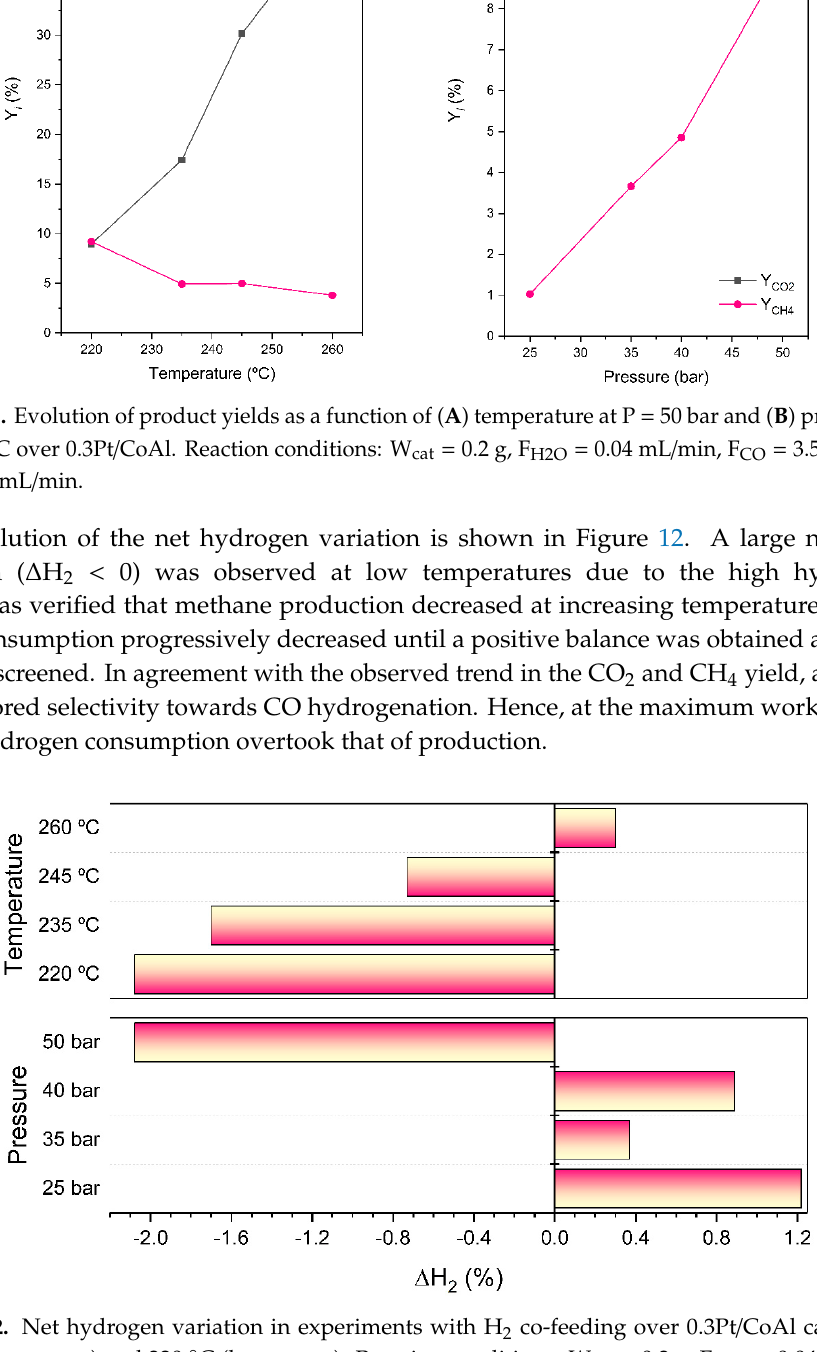
Figure 12. Net hydrogen variation in experiments with H 2 co-feeding over 0.3Pt/CoAl catalyst at 50 bar (upper part) and 220 °C (lower part). Reaction conditions: W cat = 0.2 g, F H2O = 0.04 mL/min, F CO = 3.5 mL/min, F H2 = 14 mL/min.